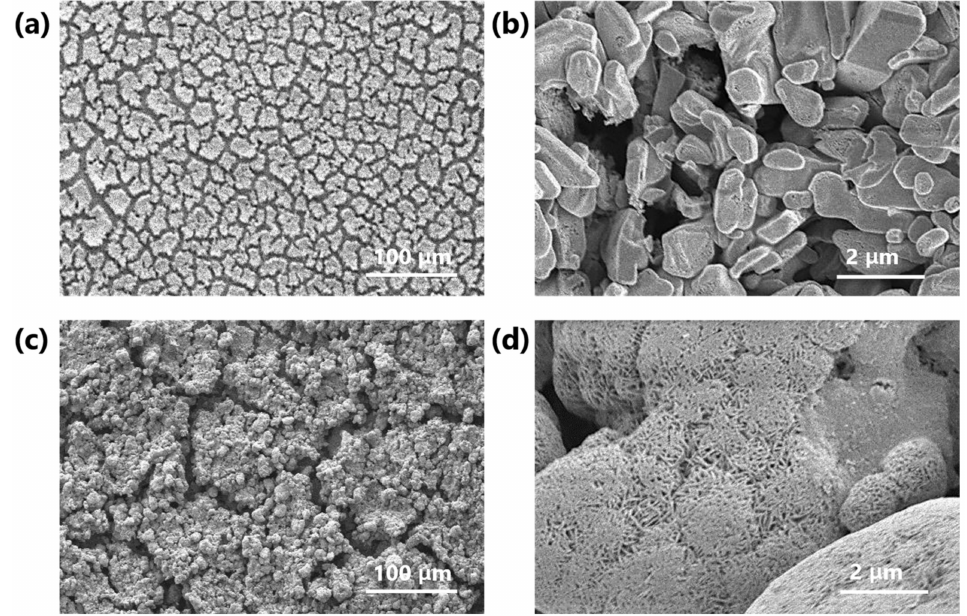
Figure 3. SEM micrographs of synthesized TiO 2 ( a , b ), and 52-300BLF ( c , d ) at the magnifications of 400 × (left) and 20,000 × (right).